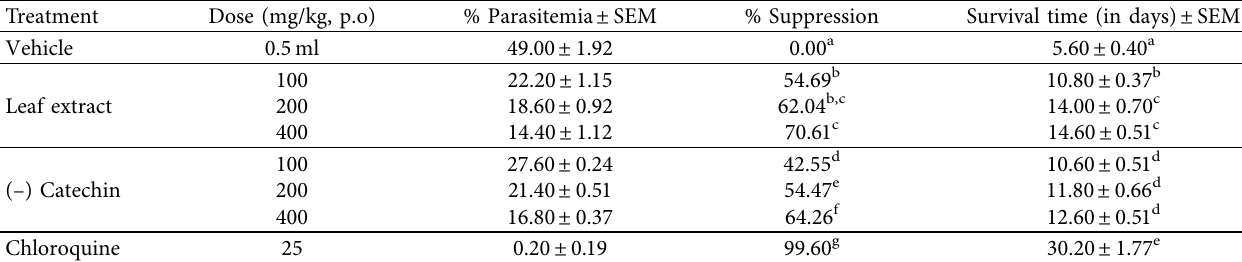
Table 1: Percentage suppression and mean survival time of Plasmodium berghei -infected mice after administration of 80% methanol leaf extract of Osyris quadripartita and its constituent ( − )